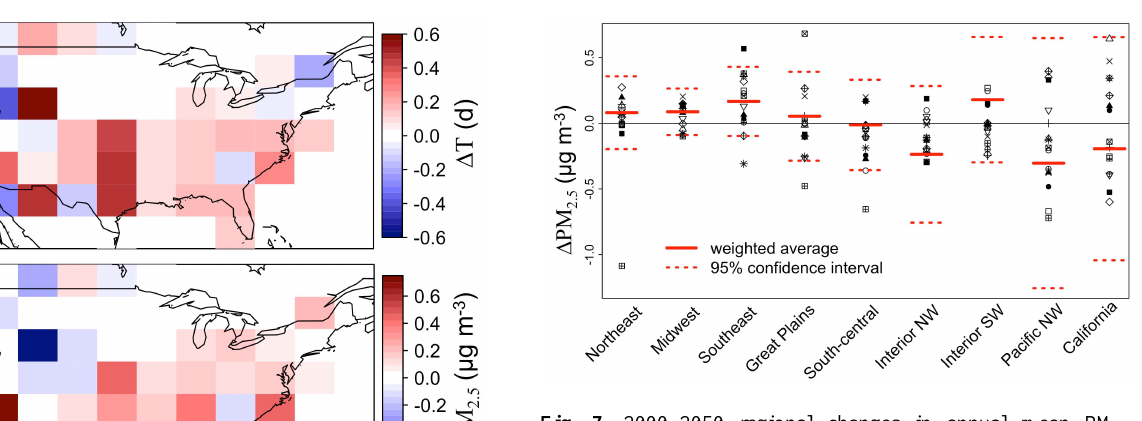
Fig. 7. 2000–2050 regional changes in annual mean PM 2 . 5 ( 1 PM 2 . 5 ) due to changes in the periods of dominant meteorologi- cal modes for nine US regions. Regional division follows that of Tai et al. (2012). Symbols represent individual IPCC AR4 GCMs (see Fig. 4). Weighted averages and confidence intervals are calculated using the Bayesian-REA approach from Tebaldi et al. (2004, 2005).